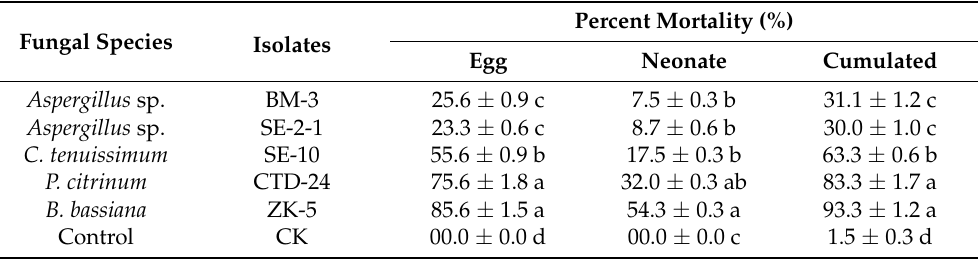
Table 6. Effects of fungal isolates on cumulative mortalities of eggs and neonates at 1 × 10 8 conidia mL − 1 . Fungal Species Aspergillus sp. Aspergillus